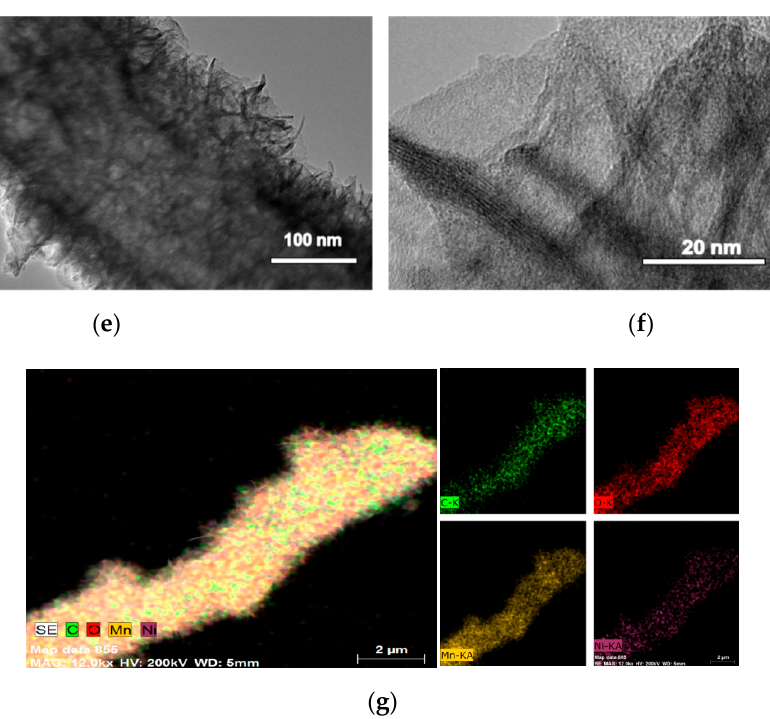
Figure 2. Electron micrographs of the MnO 2 –Ni foam and MnO 2 –MWNT–Ni foam composites, and EDS mapping of the MnO 2 –MWNT–Ni foam composite. ( a – d ) SEM images and ( e – f ) TEM images: